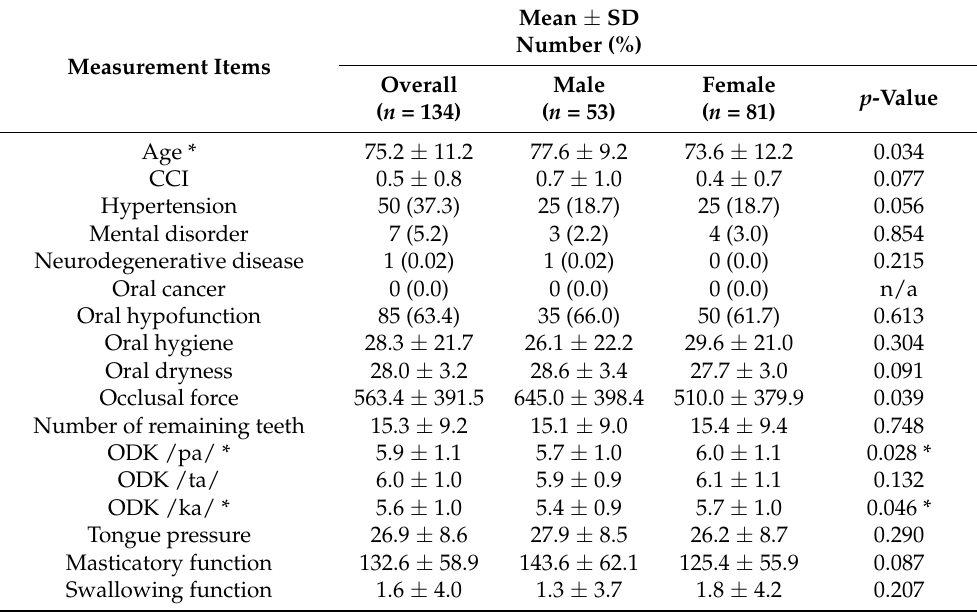
Table 1. Patient characteristics.